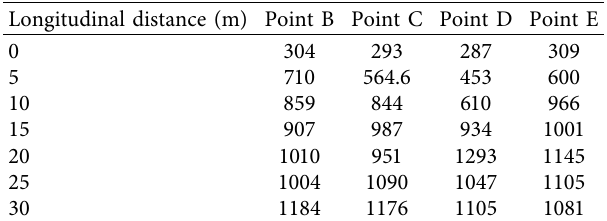
Figure 3: The temperature distribution of different sections in longitudinal direction K. (a): 0m; (b) 15m; (c) 30m. Table 1: The peak temperature inside of the tunnel lining structure after the first 20 iterations (K).